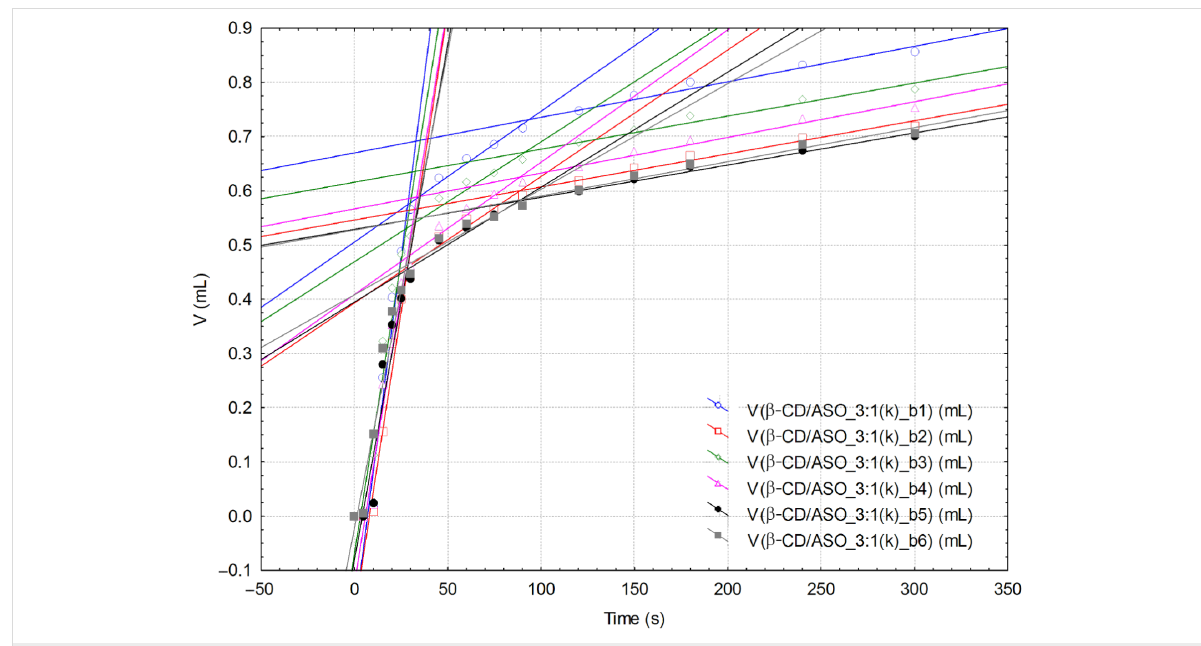
Figure 5: Superimposed volume versus time linear correlations (all three specific intervals) from the KFT analysis of β -CD/ASO_3:1(k) (only the second replicate “b” of the complex is presented; there are six